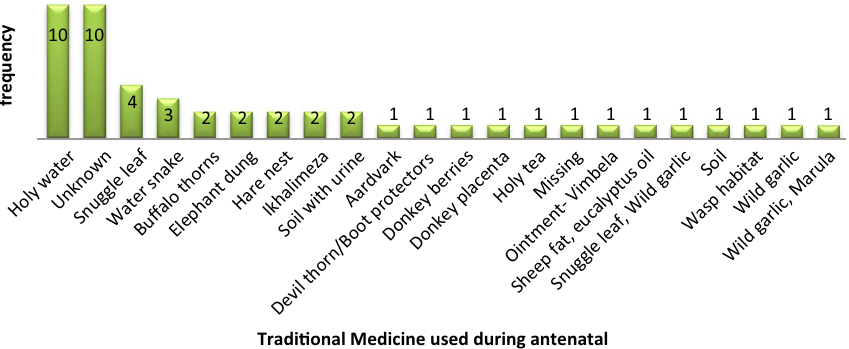
Figure 2. Traditional medicine used during antenatal (n = 50).